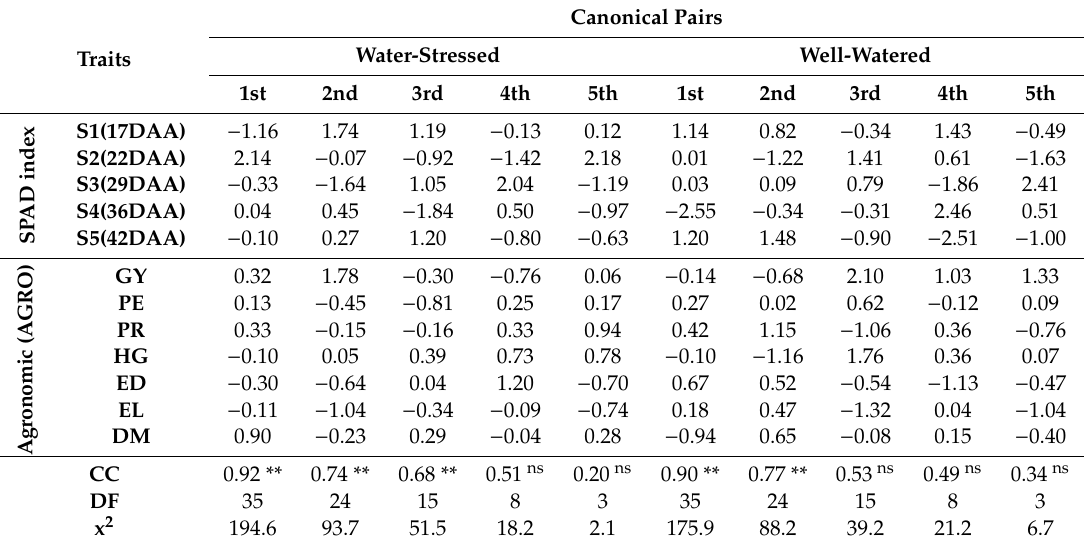
Table 2. Correlation and coe ffi cients of canonical pairs estimated between SPAD index and agronomic traits in 20 popcorn inbred lines under two di ff erent water